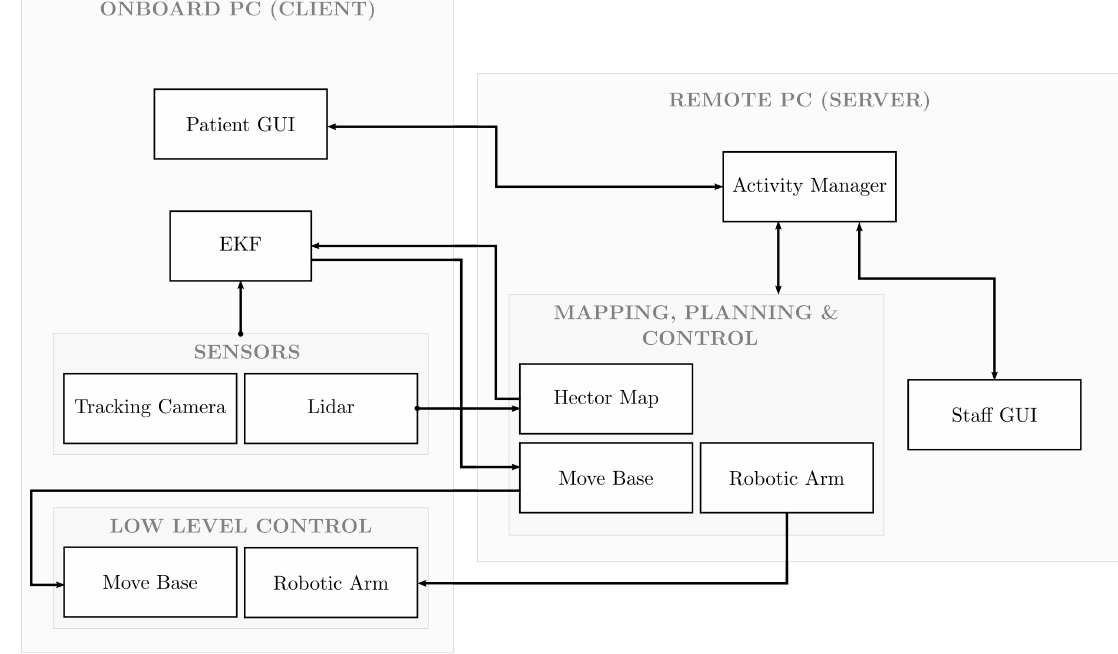
Figure 6. Schematic representation of the High-Level Control Architecture